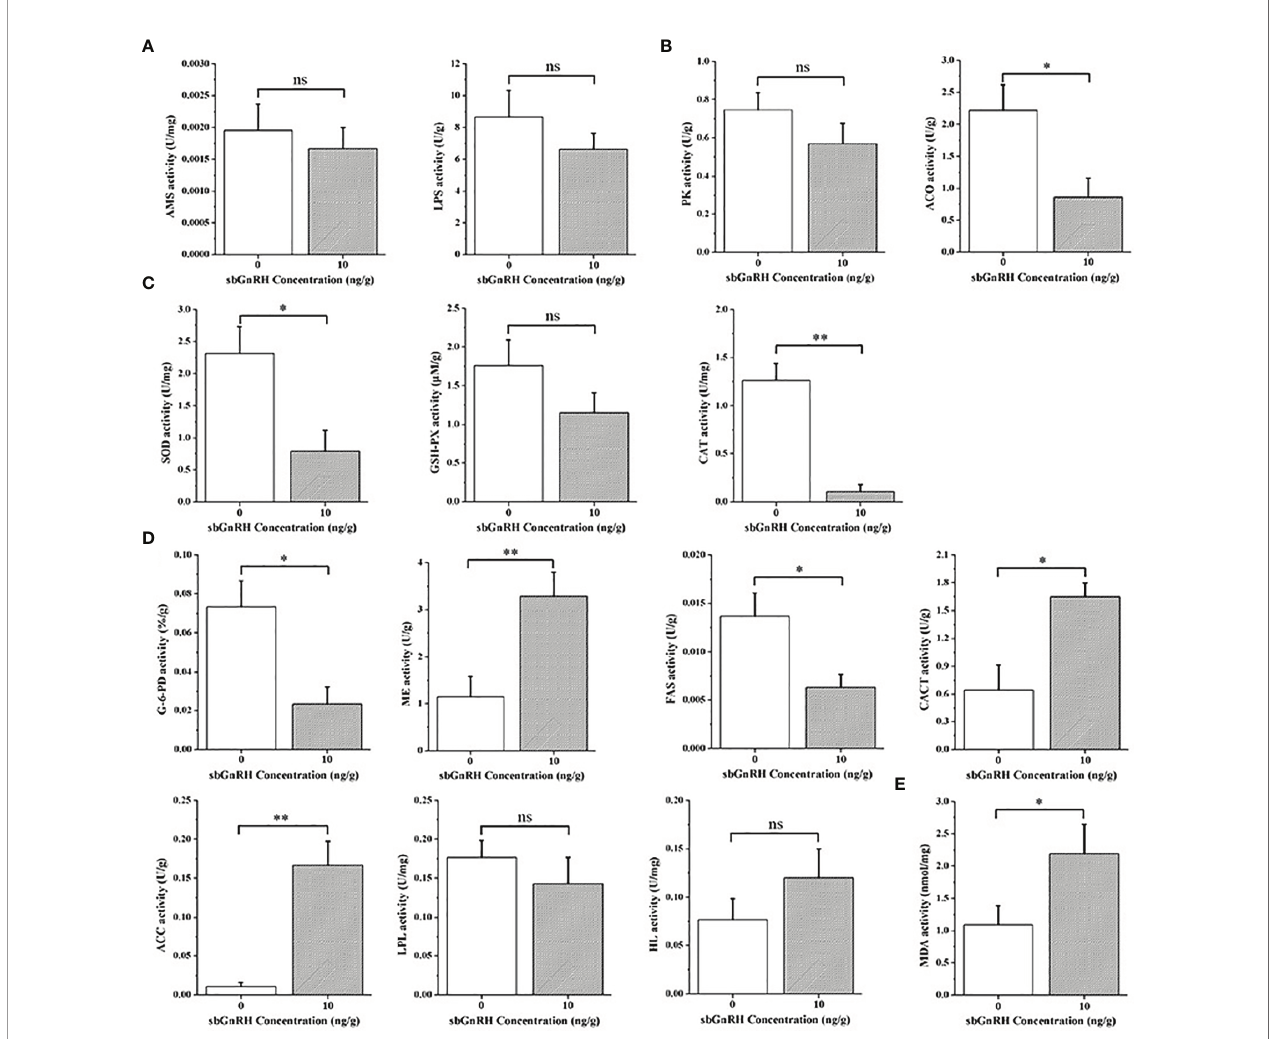
FIGURE 2 | Comparative evaluation of related liver enzyme activities between control group and treatment group. (A) digestion; (B) carbohydrate metabolism- related enzymes; (C) antioxidant defense; (D) lipid metabolism; (E) Membrane lipid peroxidation. Data are expressed as mean ± standard error (SEM) (n = 3), and the statistical signi fi cance (compared with the control group) was calculated using one-way analysis of variance (ANOVA), followed by Duncan ’ s post hoc test. * and ** indicate statistical differences at P < 0.05 and P < 0.01, respectively. ns, not signi fi cant ( P > 0.05).